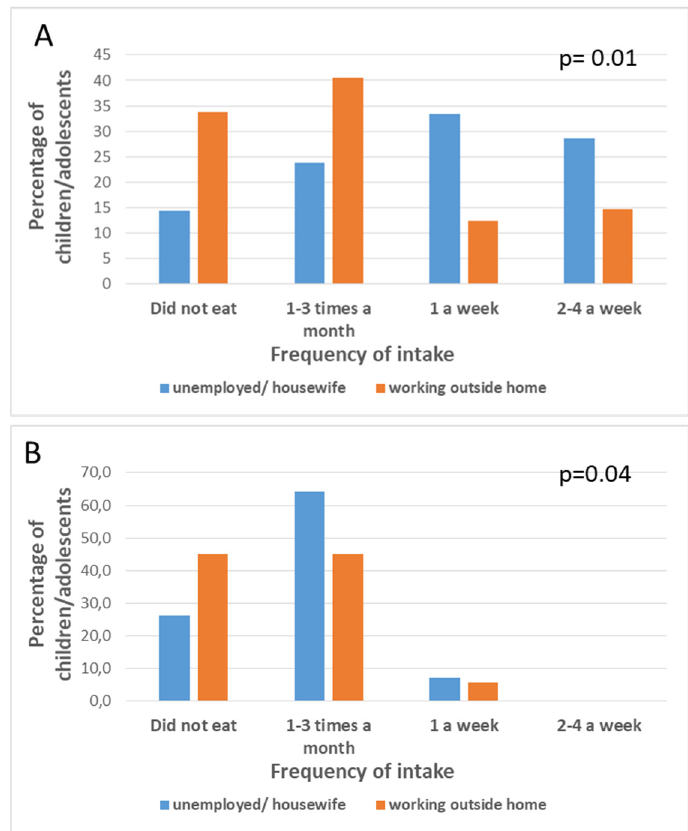
Figure 1. Frequency of intake (expressed as percentage of children/adolescents in the sample) for lean fish ( A ) and fatty fish ( B ) in children/adolescents whose mothers are unemployed /housewife or work outside home.